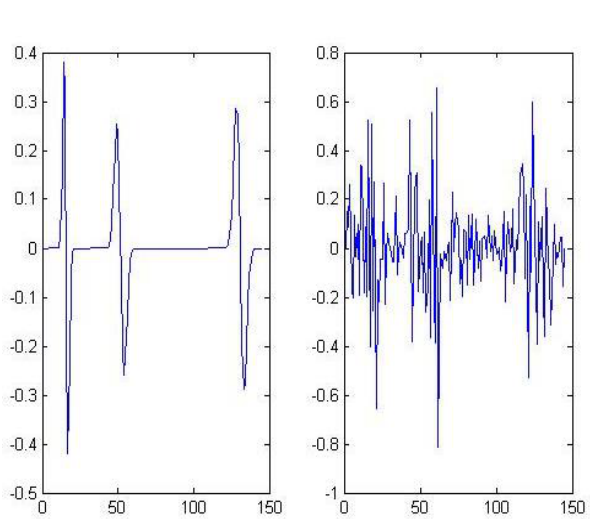
Fig.6: Derivate of fitted and real data of SSUMI